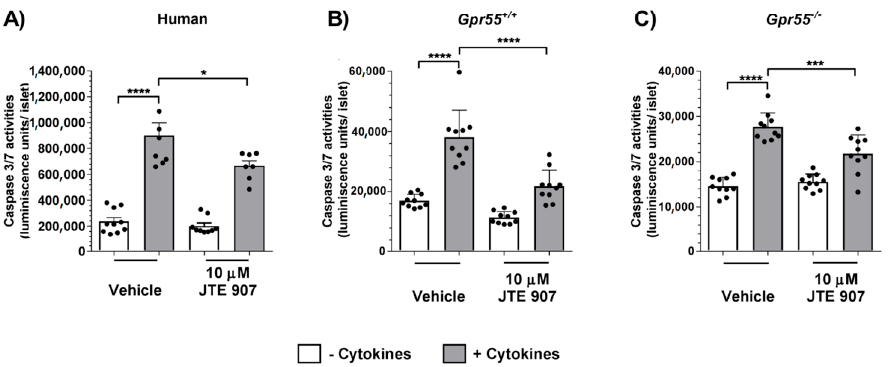
Figure 2. Effects of JTE 907 on human and mouse islet apoptosis. 10 µ M JTE 907 significantly protected against cytokine-induced apoptosis in human ( A ) and mouse ( B , C ) islets, but had no significant effect on basal apoptosis. Data show mean + SEM data of 8–10 observations per treatment group that are representative of 3 independent experiments using both mouse and human